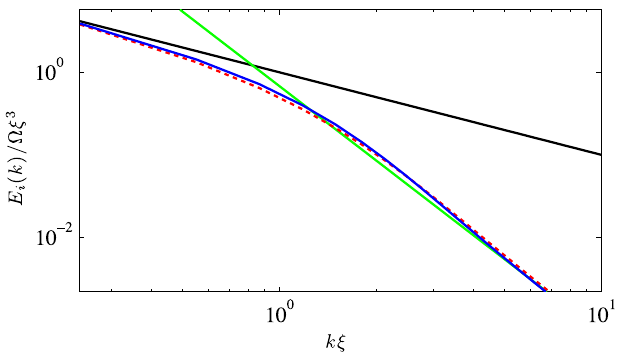
FIG. 2. Comparison of the numerically computed kinetic- energy spectrum [(35), blue solid line] and that obtained from ð k(cid:1) Þ [(46), red dashed line] in the crossover the core function F (cid:3) regime k(cid:1) (cid:8) 1 . The asymptotic expressions (38) and (39) are shown by the black and green lines, respectively.